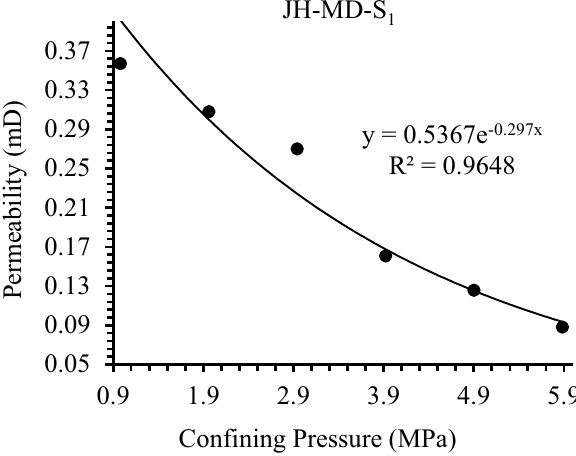
Fig. 8 Variation of permeability with gas pressure